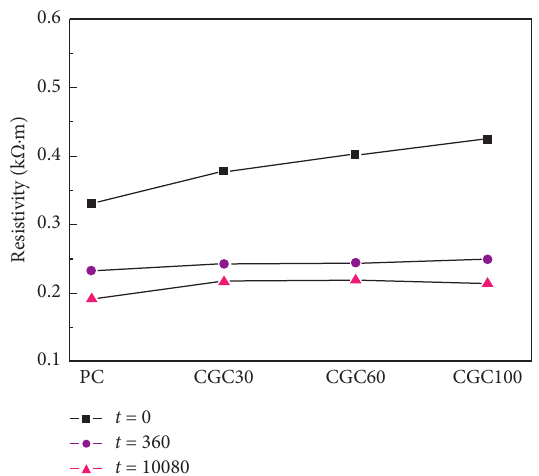
Figure 10: Influence of coal gangue ceramsite on electrical resistivity of concrete.